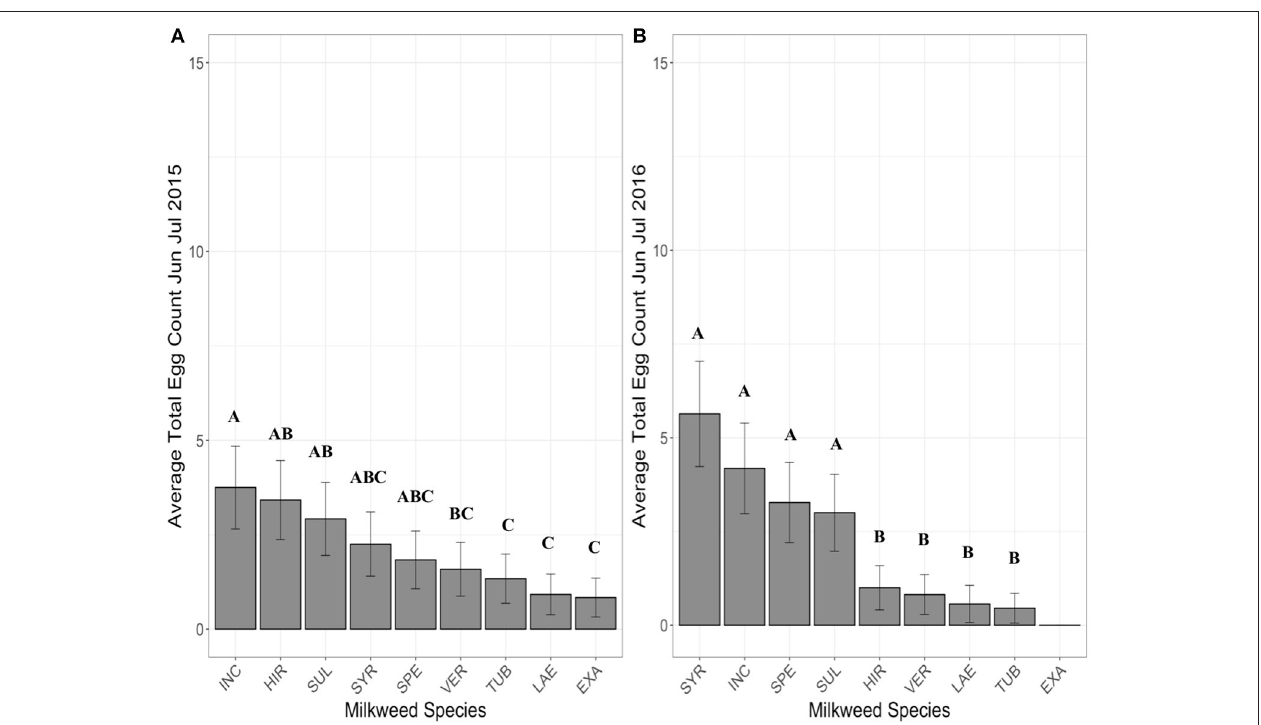
FIGURE 2 | Average eggs counted on each milkweed species in June and July in 2015 (A) , 2016 (B) when 5 plants of each species were present in each research plot. Each bar represents one milkweed species. EXA, A. exaltata ; HIR, A. hirtella ; INC, A. incarnata ; LAE, C. laeve ; SPE, A. speciosa ; SUL, A. sullivantii ; SYR, A. syriaca ; TUB, A. tuberosa ; VER, A. verticillata; error bars represent 95% confidence intervals. N = 11 sites in 2015, and 12 sites in 2016. Bars that share a letter within each panel are not significantly different from each other. Females laid more eggs on A. incarnata than on A. exaltata, C. laeve, A. tuberosa, and A. verticillata in both years ( p < 0.05). The number of eggs laid on A. syriaca was not significantly different from A. incarnata . P -values were adjusted using the Tukey method for multiple